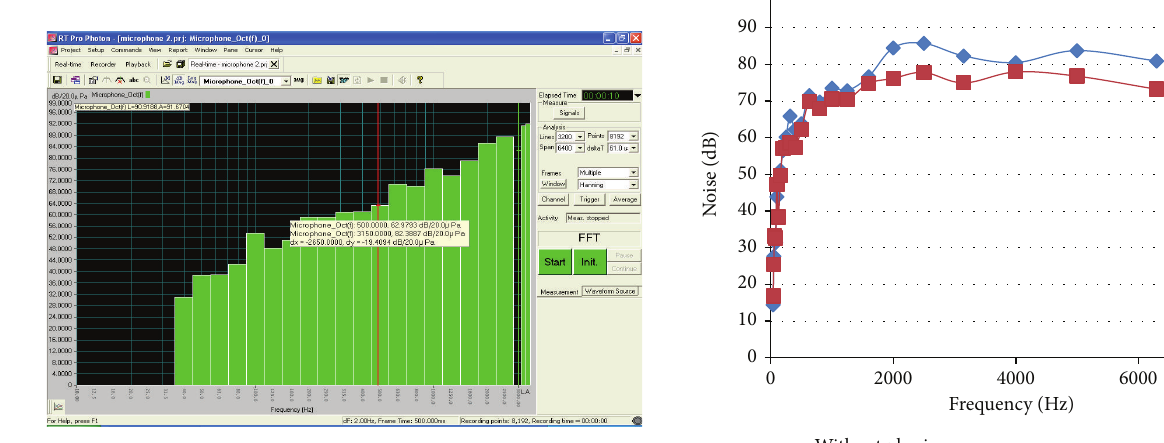
Figure 10: Variation of noise (dB) with frequency (Hz) at 1200rpm for 6Kg load without phasing.